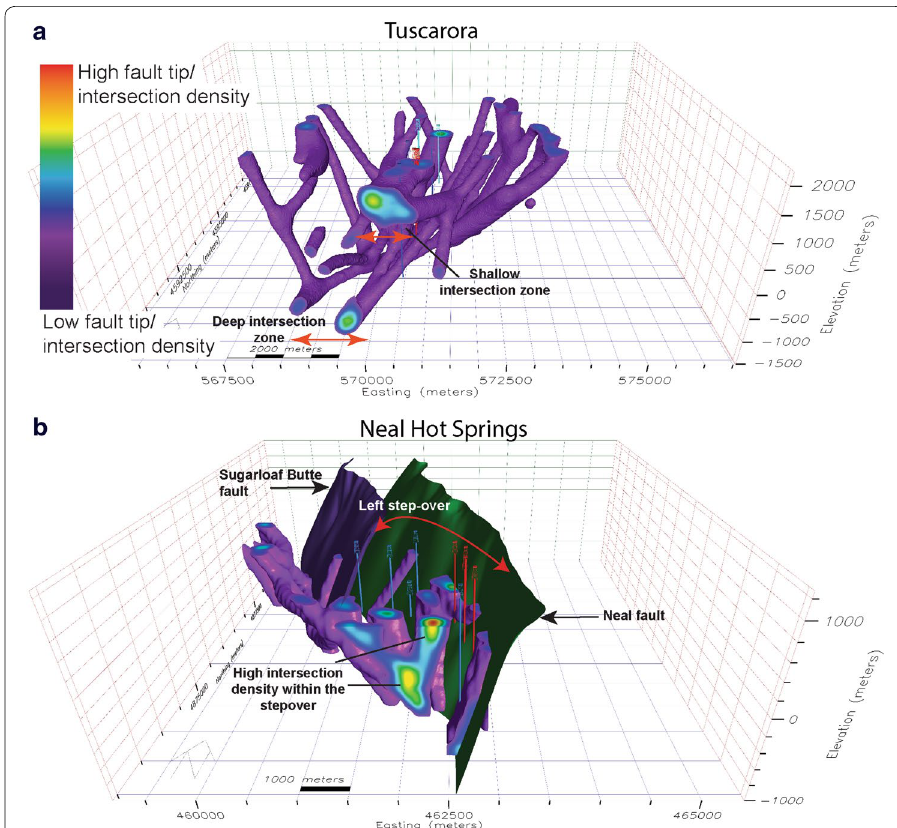
Fig. 11 Calculated density of fault intersections and fault tips in a the Tuscarora area, and b the Neal Hot Springs area. Warm colors represent a high spatial density of fault intersections and fault terminations. In these locations there is a relatively higher likelihood for dense, interconnected fracture networks, as well as a relatively high potential for geothermal fluid flow. The isolated columns indicate the intersection of two faults or one fault termination. Larger volumes correspond to progressively higher fault intersection/termination densities. a At Tuscarora within the accommodation zone there are two sub-horizontal areas of relatively high intersection density at ~ 1200 m elevation (~ 3000 m depth) and at ~ 600 m elevation (~ 1200 m depth). b At Neal Hot Springs, the highest intersection density occurs within the step-over between The Neal fault (right) and Sugarloaf Butte fault